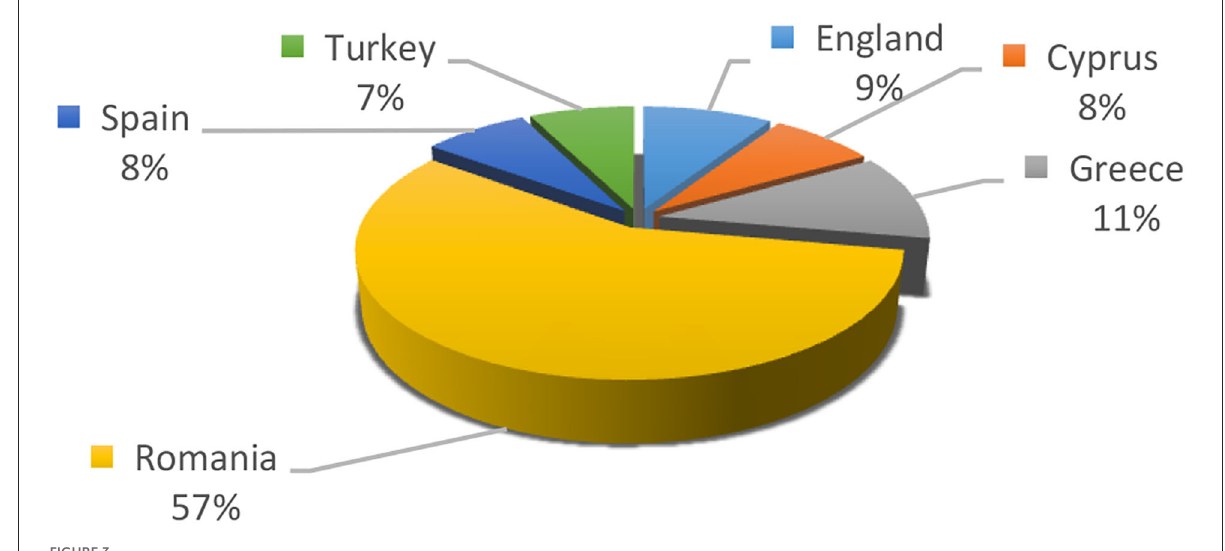
FIGURE3 Geographical overview of